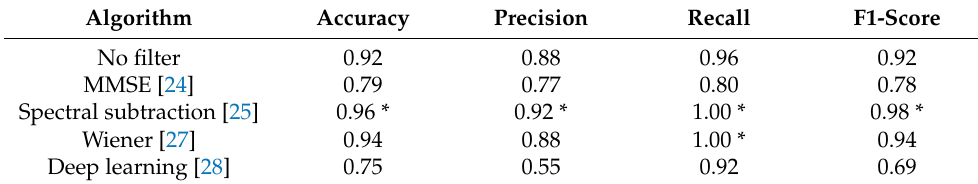
Table 13. Office Noise SNR 0. * is the best result for each particular measure.